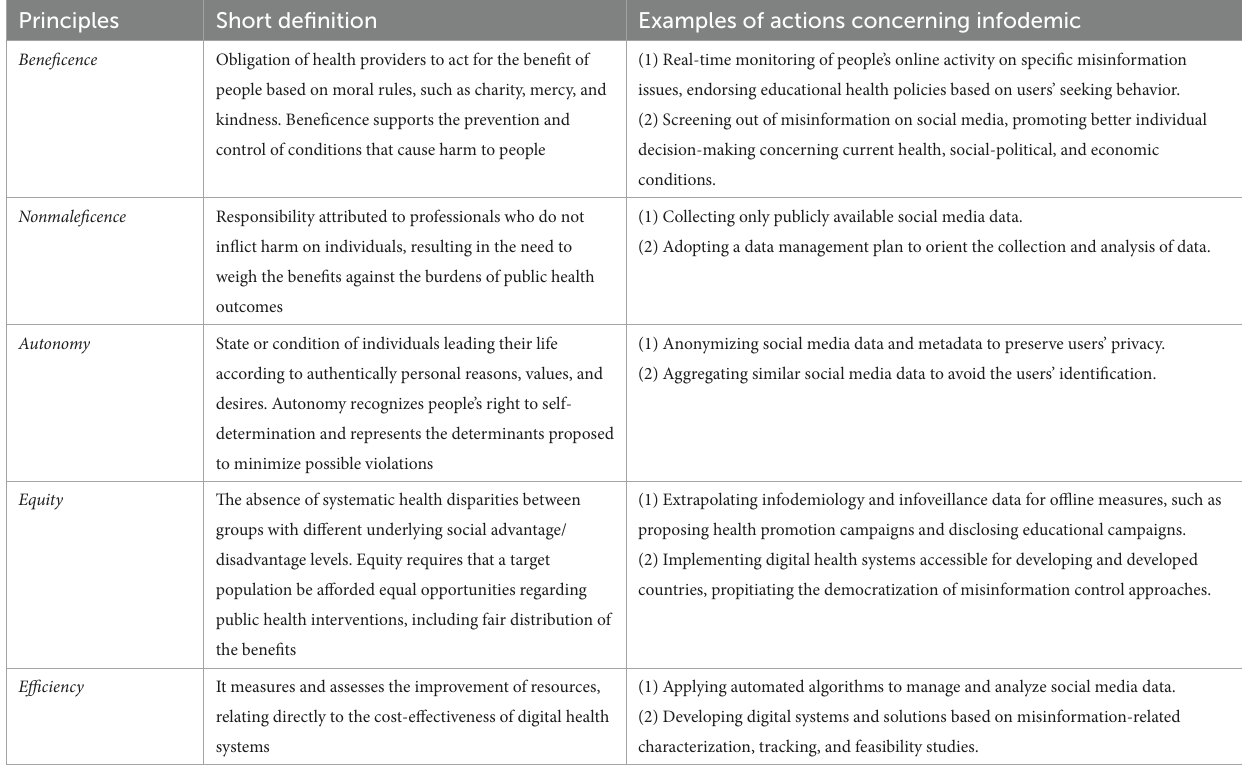
TABLE 1 Ethical principles to orient infodemiology and infoveillance studies for infodemic perspectives.